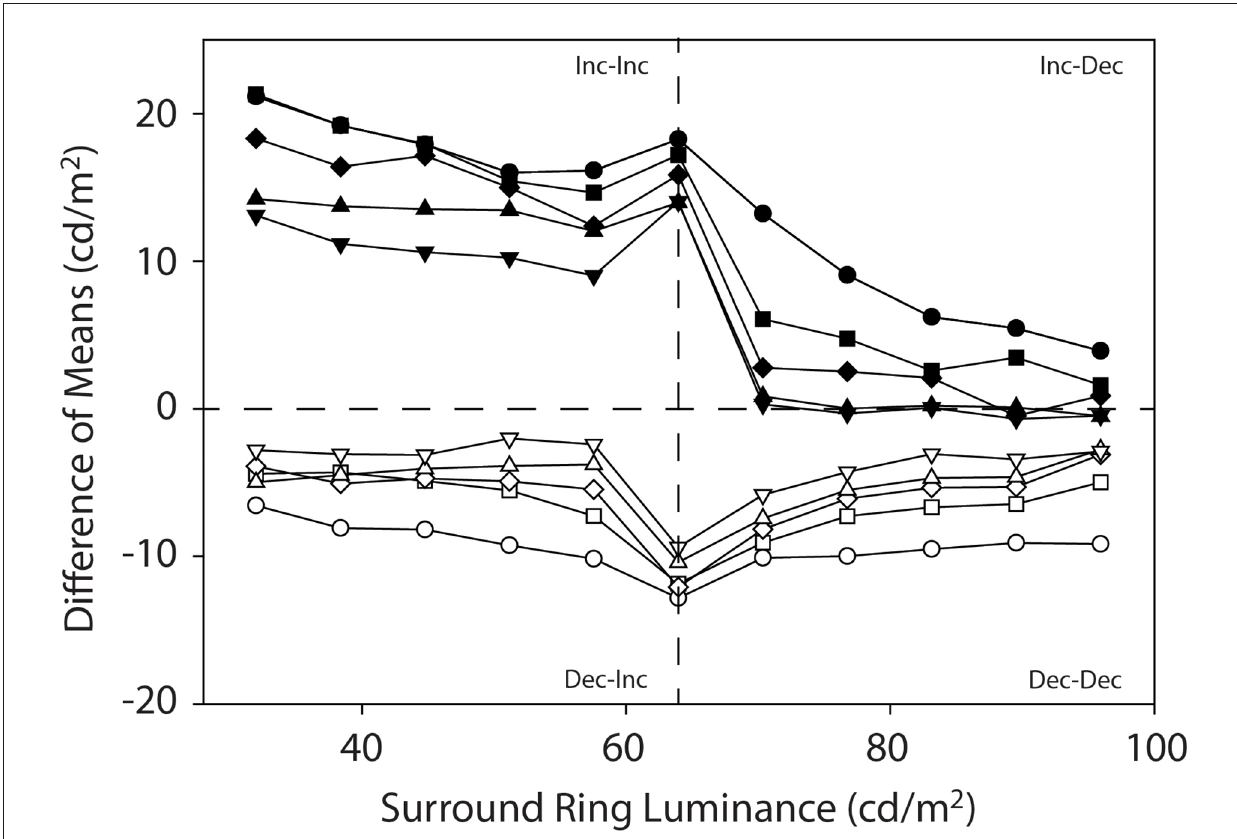
FIGURE6 Mean target patch matching luminance plotted as difference functions. Here the filled symbols reflect the difference between the target patch matching functions on the 0.0 cd/m 2 and 64 cd/m 2 remote backgrounds and the open symbols plot the difference between the target patch matching functions on the 64 cd/m 2 and the 96 cd/m 2 remote backgrounds. This differencing operation is another way to visualize the direction and strength of induction from the dark (0.0 cd/m 2 ) and bright (96 cd/m 2 ) remote backgrounds in greater isolation from the induction due to the variable adjacent surround-ring luminance (64 cd/m 2 background). The labels (Inc-Inc, Inc-Dec, Dec-Inc and Dec-Dec) describe the luminance relationships between the remote background, adjacent surround-ring and target patch (see text for